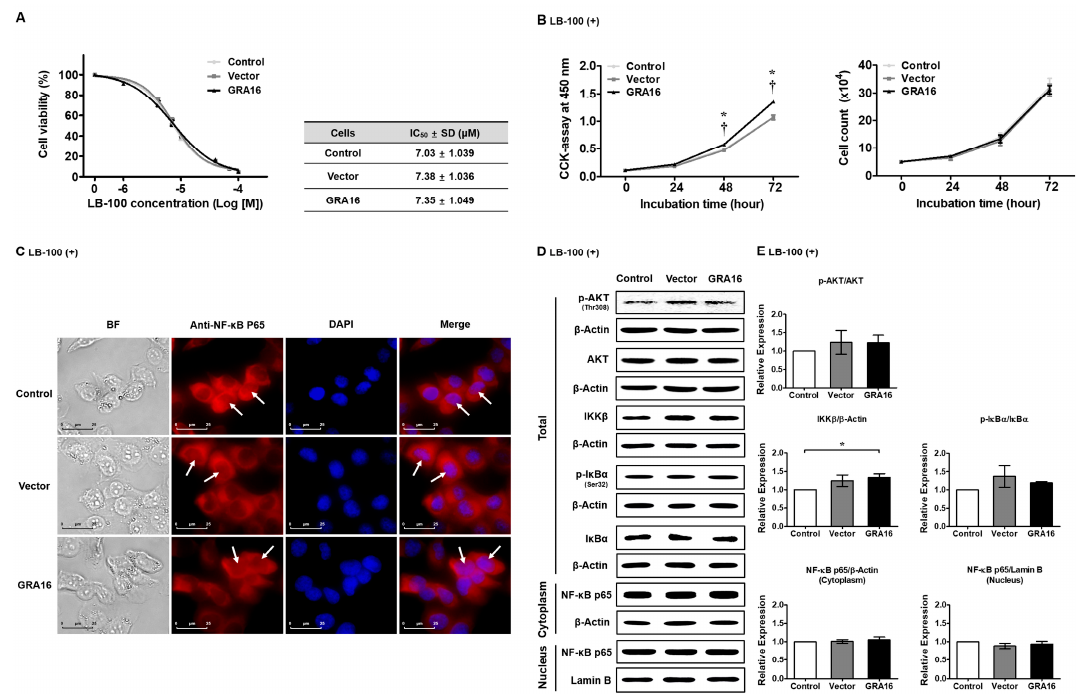
Figure 6. Treatment with LB-100, a PP2A inhibitor, reverses the reduced cell viability, AKT dephosphorylation, and NF- κ B inactivation induced in GRA16 cells. ( A ) IC 50 of LB-100 in NSCLC cells. ( B ) Cell viability and total cell count after treatment with 7 µ M (as determined by the IC 50 result) LB-100. ( C ) Immunofluorescence images of NF- κ B distribution in the cytoplasm and nucleus. BF: bright field, DAPI: nucleus staining. White arrows represent NF- κ B p65 protein in the nucleus. Scale bar represents 25 µ m. Western blots of p-AKT, AKT, IKK β , p-I κ B α , I κ B α , and NF- κ B p65 in control, vector, and GRA16 cells ( D ) and their relative expressions ( E ). * significant at p < 0.05 between control and GRA16 cells; † significant at p < 0.05 between vector and GRA16 cells.